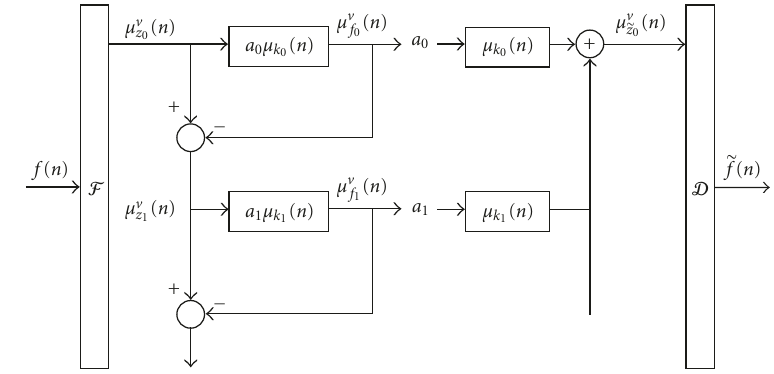
Figure 5: FMP representation block diagram.